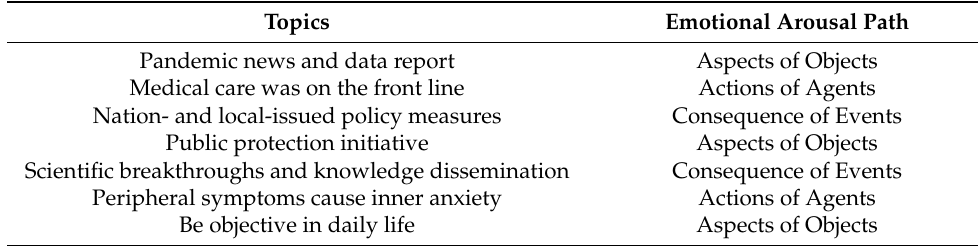
Table 2. Seven Topics and Three Emotional Arousal Paths.